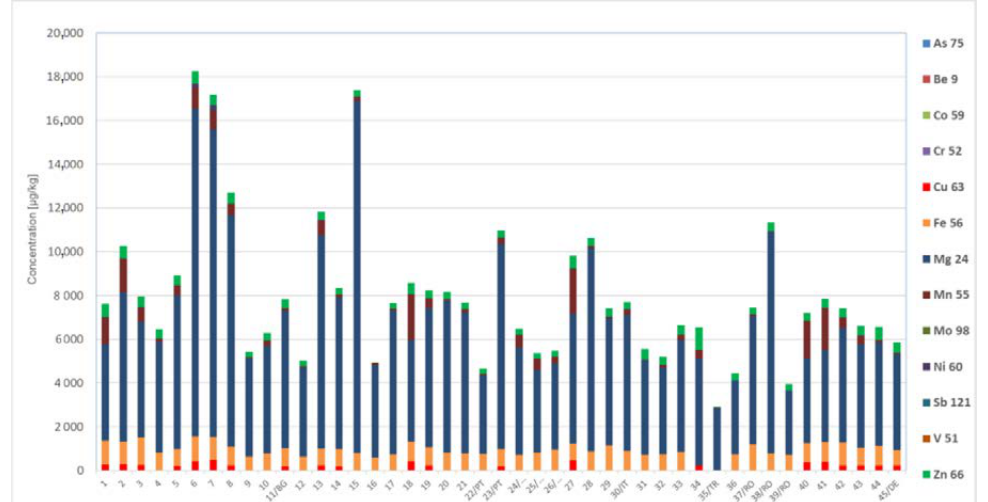
Figure 5 . Comparative analysis of honey samples on the content of selected bioelements. Figure 5. Comparative analysis of honey samples on the content of selected